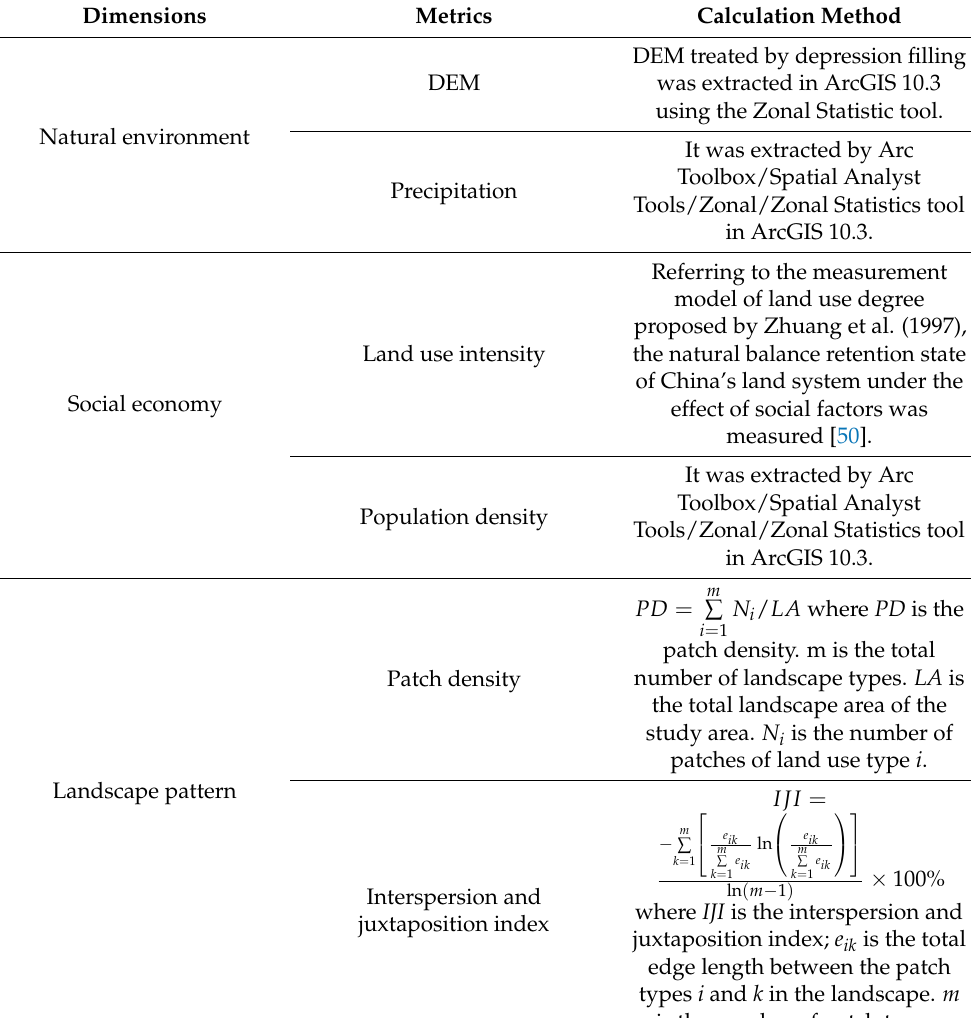
Table 3. Factors influencing the coupling coordination degree of PLES in